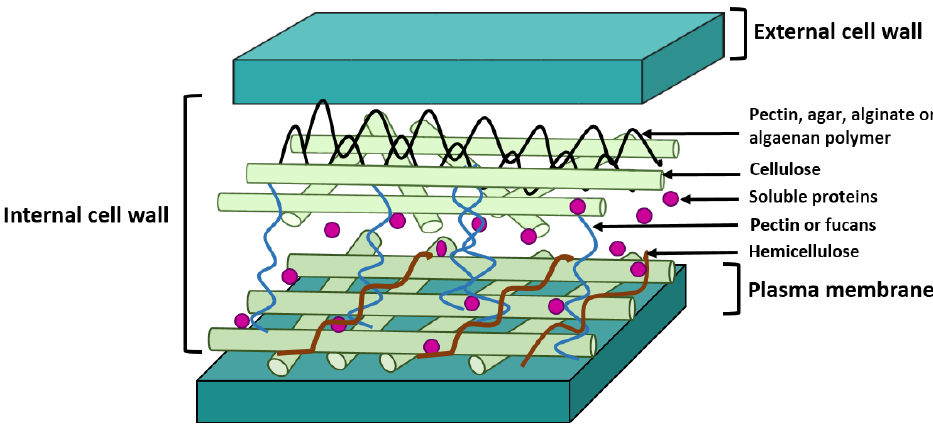
Figure 1. Composition of typical microalgal cell wall (redrawn from